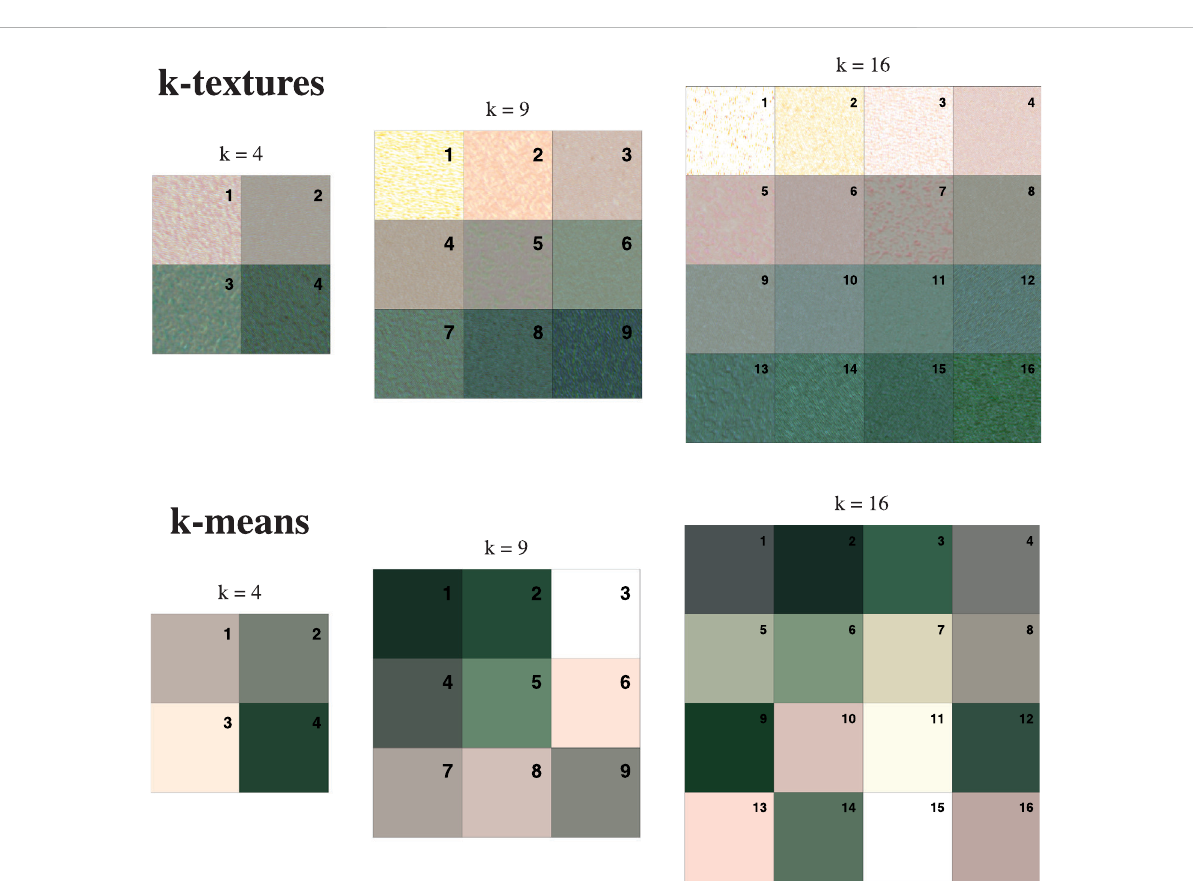
FIGURE 8 Example of the k textures simulated by the k-textures model and the colors of the cluster obtained by the k-means for k = 4, 9 and 16 classes. The matrix of textures are fi lled by row, starting by the top left, in the order returned by the models. Note that, for an easy visualization, only RGB bandsaredisplayedbuttheestimatedtextureshave4bands,RGBandNIR.Forthek-texturesmodelof9classes,theforestsaremostlyencountered inthecluster8and9;thesavanna,grasslandandwaterbodiesareincluster8,7and6;andclusterslowerthan5arerelatedtopastureandurban areas, see Table